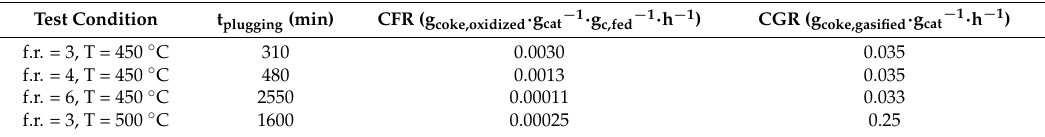
Table 4. Plugging time corresponding to 500 mbar (t plugging ), carbon formation rate (CFR) and